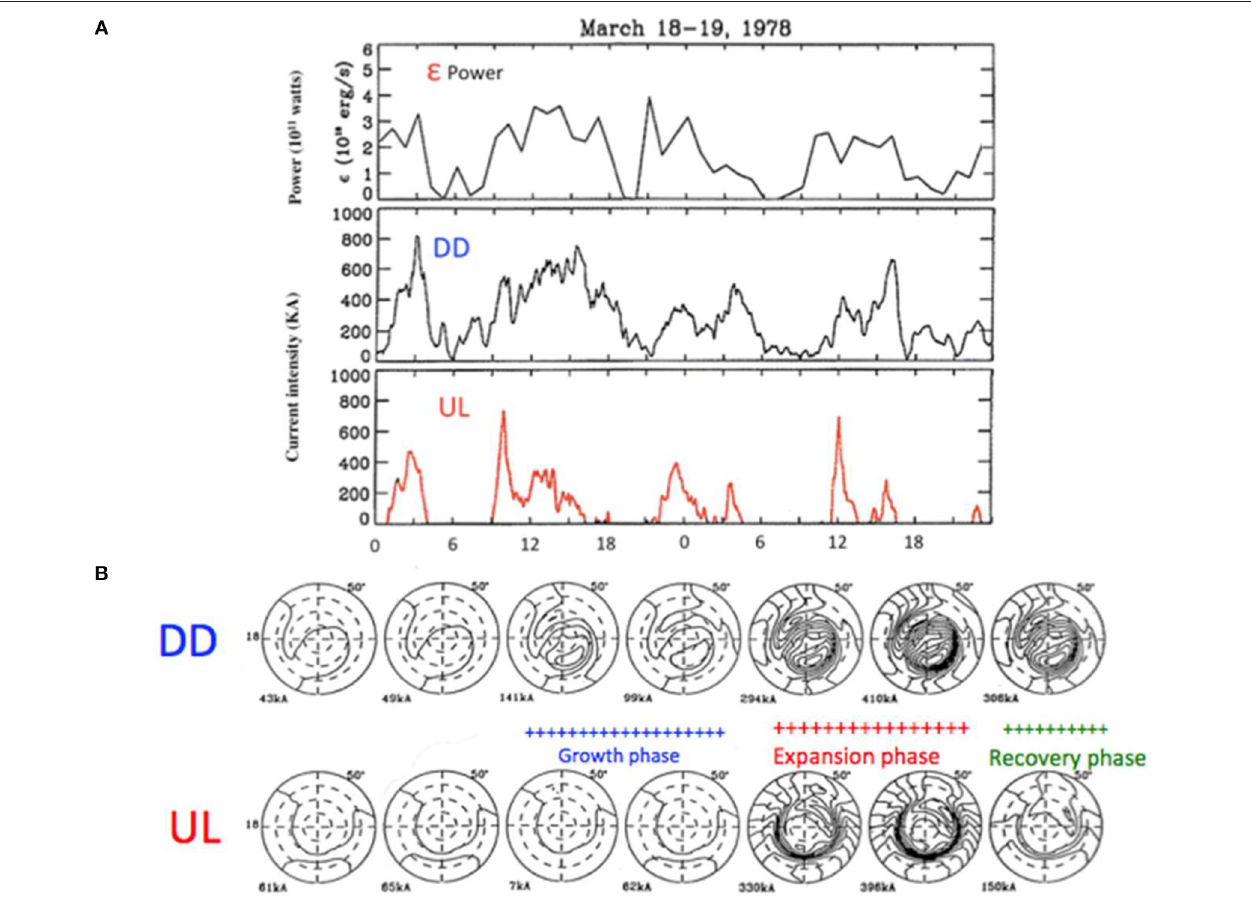
FIGURE 10 | (A) from the top, the dynamo power ( ε ), the current intensity of the directly driven component (DD), and the current intensity generated by the unloading process (UL); the current intensity is proportional to the Joule heating production rate in the ionosphere. (B) the current distribution of both the DD and UL components during the last subtorm in Figure 10A . Note that the DD current was weak during the growth phase, so that the ionosphere could not dissipate the incoming power. Because of this situation, the dynamo power is accumulated in the inductive circuit in the main body of the magnetosphere. Note also that the DD component is intensified during and after the expansion phase, because the conductivity is greatly enhanced during the expansion